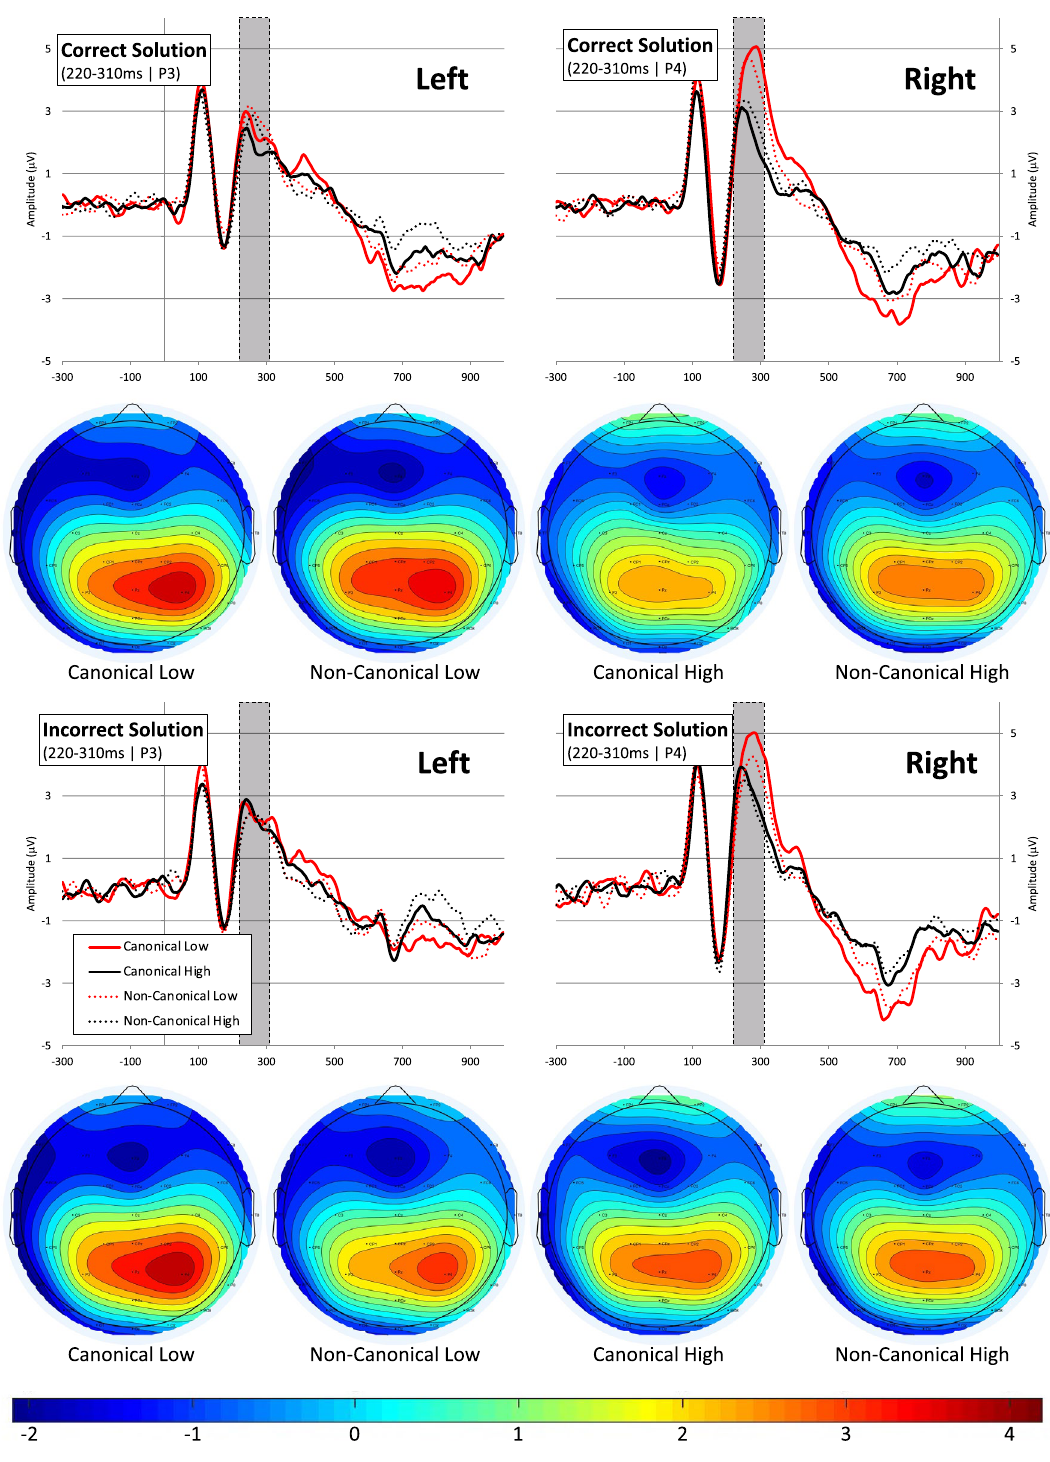
Figure 2. Grand average ERP’s at the left parietal (P3) electrode (left panel) and the right parietal (P4) electrode (right panel) with the P2p time window used in the analysis indicated by the grey bar. Topography plots for the 220–310 ms (P2p) time-window are shown separately for correct (top panel) and incorrect (bottom panel) sum solution trials in the four Canonicity-Range categories: Canonical-Low, Non-Canonical-Low, Canonical- High, Non-Canonical-High. The ERP plots show the grand average ERPs and topo-plots in all conditions of the experiment for purposes of evaluation of ERP quality and choice of windows and electrodes for analyses (see: Keil et al. 37 ). For visualization of the specific interaction effects found on P2p and P3 amplitude we refer the reader to Fig. 4A. Images are created by the first author using ERPlab software 38